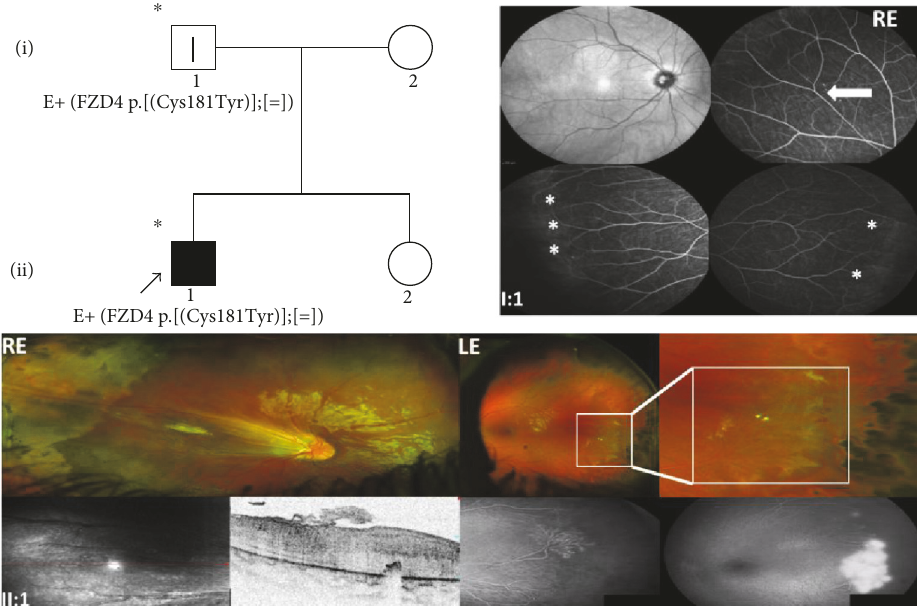
Figure 2: Pedigree and ocular features of family 2. Red-free images and fl uorescein angiograms from the proband ’ s father (I:1) showing similar fi ndings in both eyes consisting of slight abnormalities of the peripheral retinal vasculature as indicated by the arrows. The posterior pole and the mid periphery were normal. Daytona wide- fi eld color fundus photos and OCT scan of the proband (II:1) at the age of 2 years showing the presence of a falciform fold and peripheral avascular retina in the RE. The wide- fi eld angiography of the LE (early and late phases) revealed a normal posterior pole and a severe leakage from undiscovered peripheral neovascular networks that were treated promptly to avoid exudation and visual impairment. ∗ Documented clinical evaluation; E+ and E − , positive and negative to genetic test, respectively; | asymptomatic/presymptomatic carrier (stage 1 FEVR); RE, right eye; LE, left